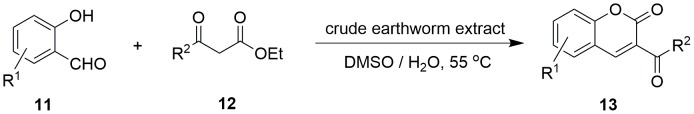
The crude earthworm extract catalysed domino reactions for the synthesis of coumarin derivatives.